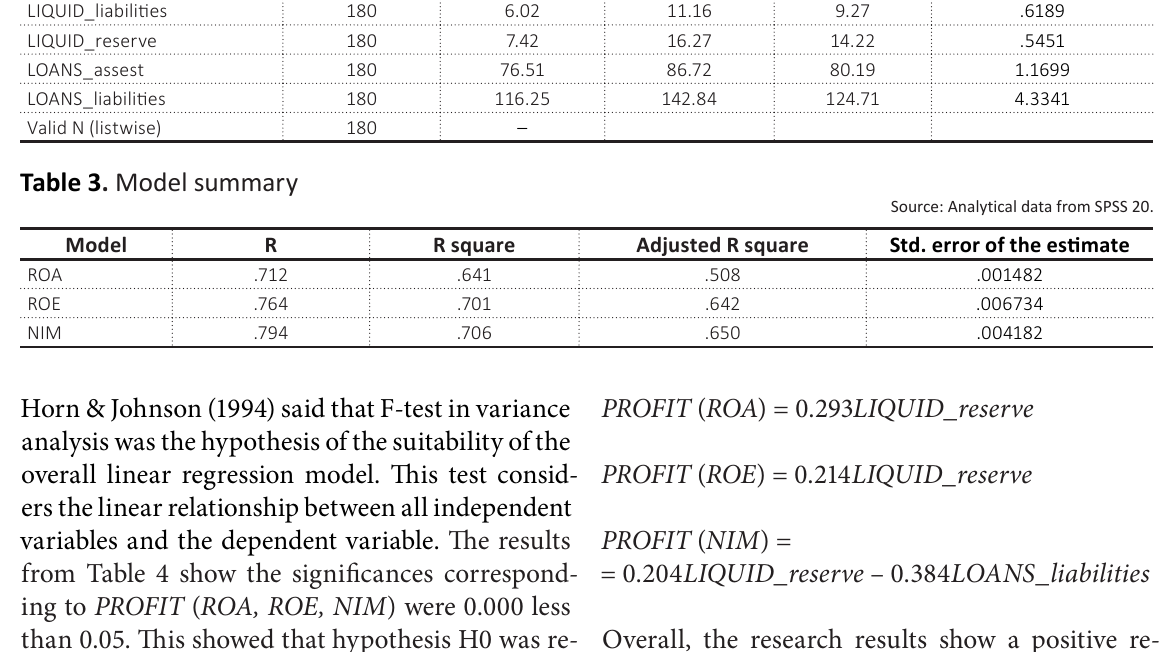
Table 2. Descriptive statistics